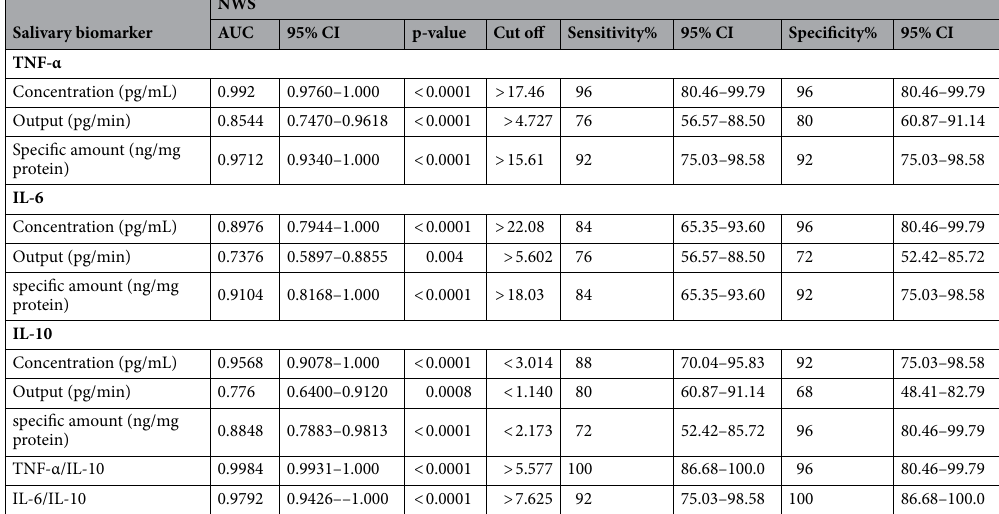
Table 6. Receiver operating characteristics of salivary cytokines in non-stimulated saliva of stroke patients and healthy controls. TNF-α–tumor necrosis factor α; IL-6 – interleukin 6; IL-10 – interleukin 10.